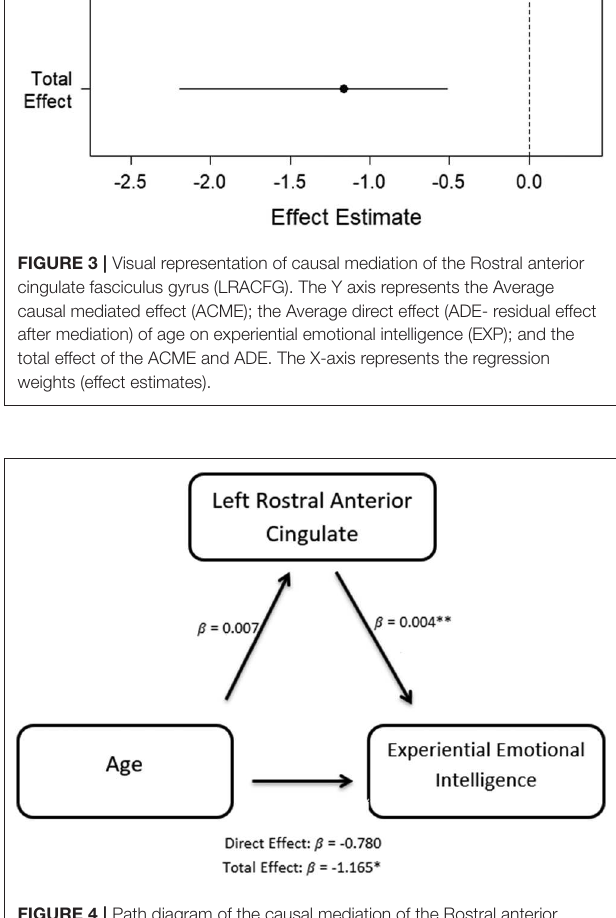
FIGURE 4 | Path diagram of the causal mediation of the Rostral anterior cingulate fasciculus gyrus (LRACFG). Given the significant negative correlation between age and EXP ( Table 1 ), and the negative direction of the regression estimates ( Figures 3 , 4 ) between LRACFG and EXP, it appears that those amongst the older aging adults with thinner LRACFG, tend to have better preserved